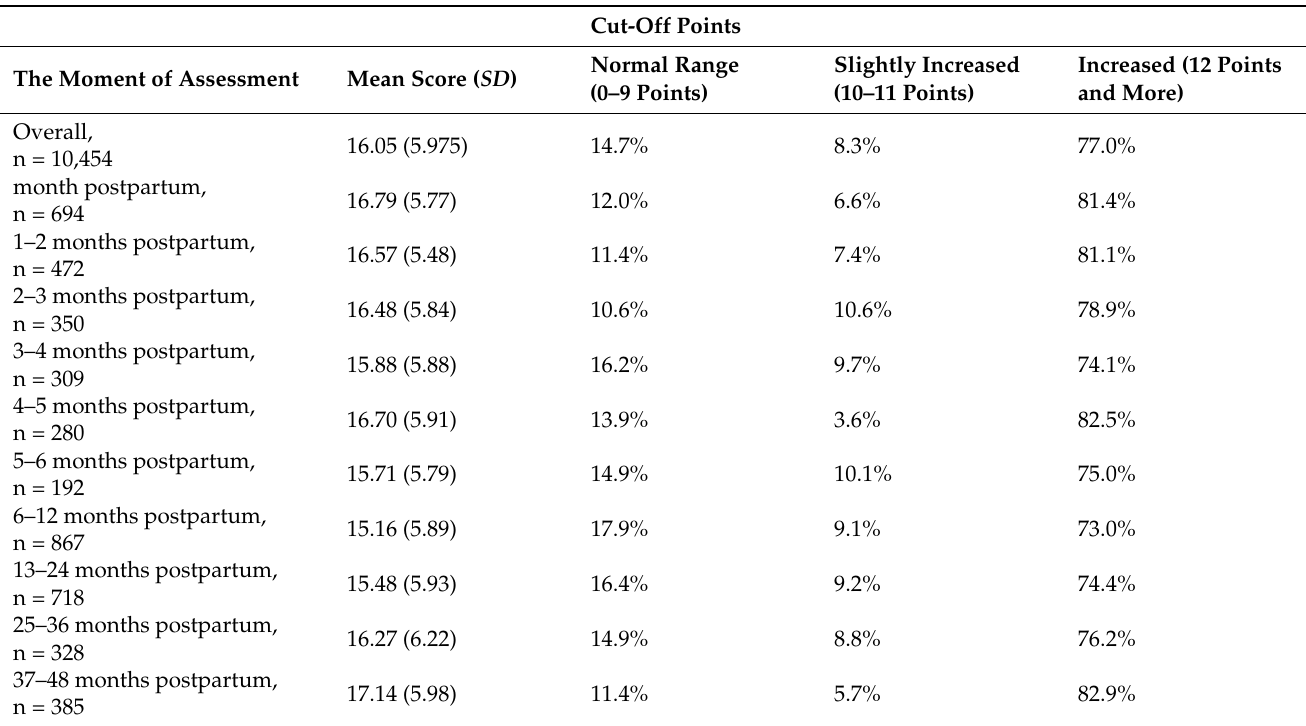
Table 2. Occurrence of the scores obtained by postpartum women in an online self-screening for PPD with EPDS (regarding the cut-off points) in the ‘Next Stop: Mum’ project, n = 10,454.